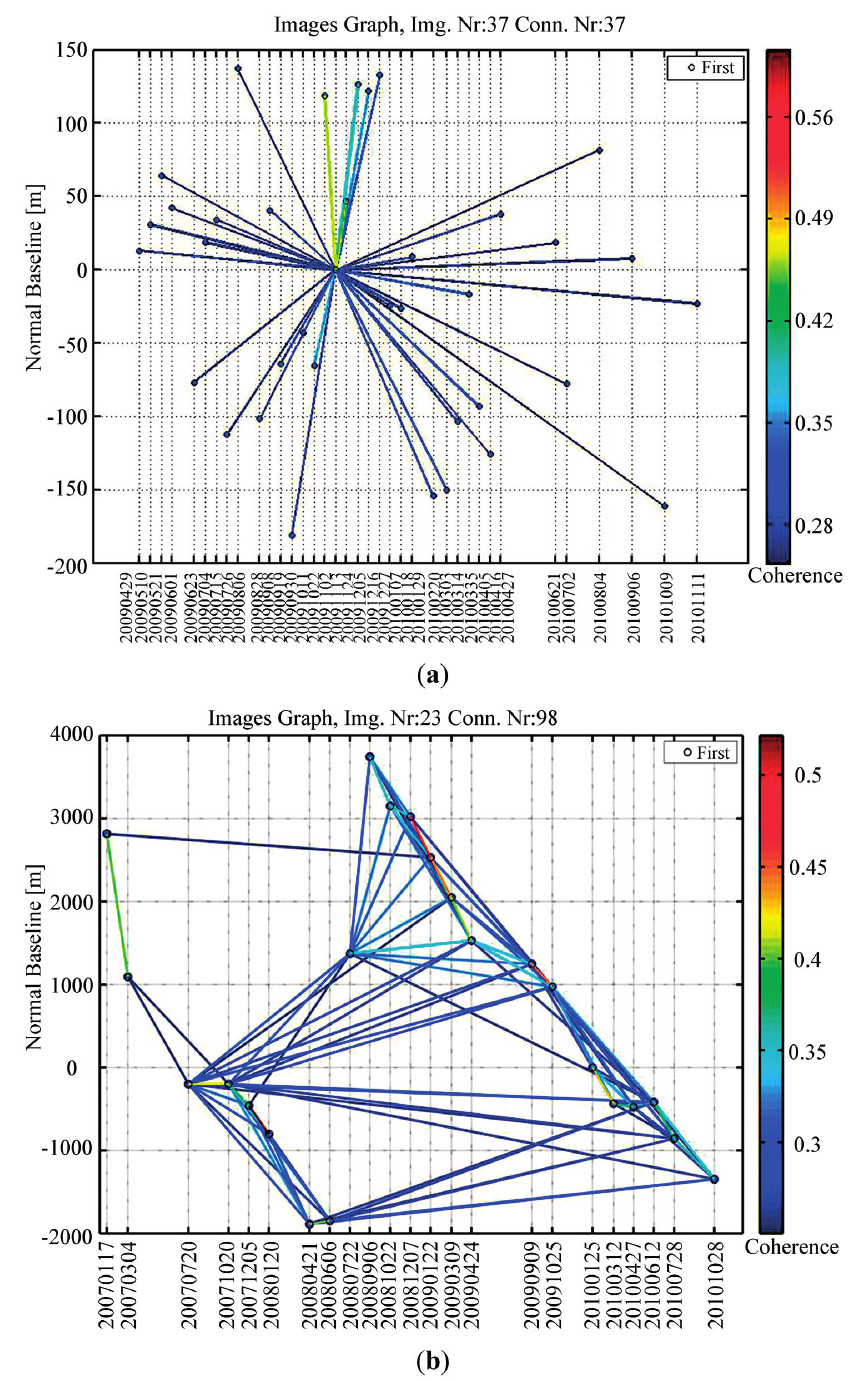
Figure 3. Images graph. X-axis: temporal baseline of the acquisitions. Y-axis: normal baseline of the acquisitions. Color scale: average spatial coherence of the corresponding interferometric link. ( a ) TSX PS analysis; ( b ) ALOS-PALSAR QPS